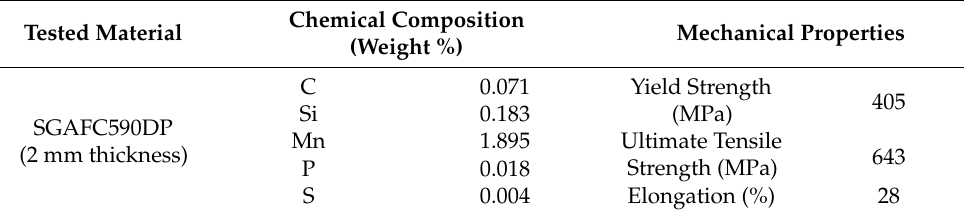
Table 1. Chemical composition (weight%) and mechanical properties of tested material [36].